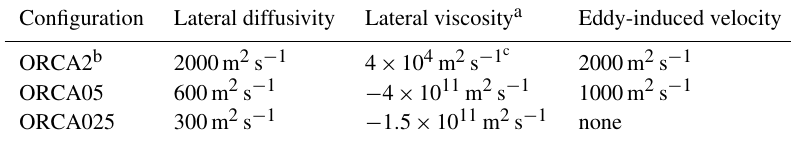
Table 2. Coefficients for lateral diffusivity, lateral viscosity, and eddy-induced velocity for ORCA2, ORCA05, and